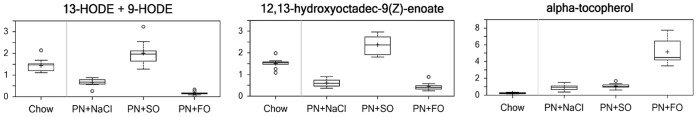
Lipid Peroxidation and Anti-oxidant Metabolites.